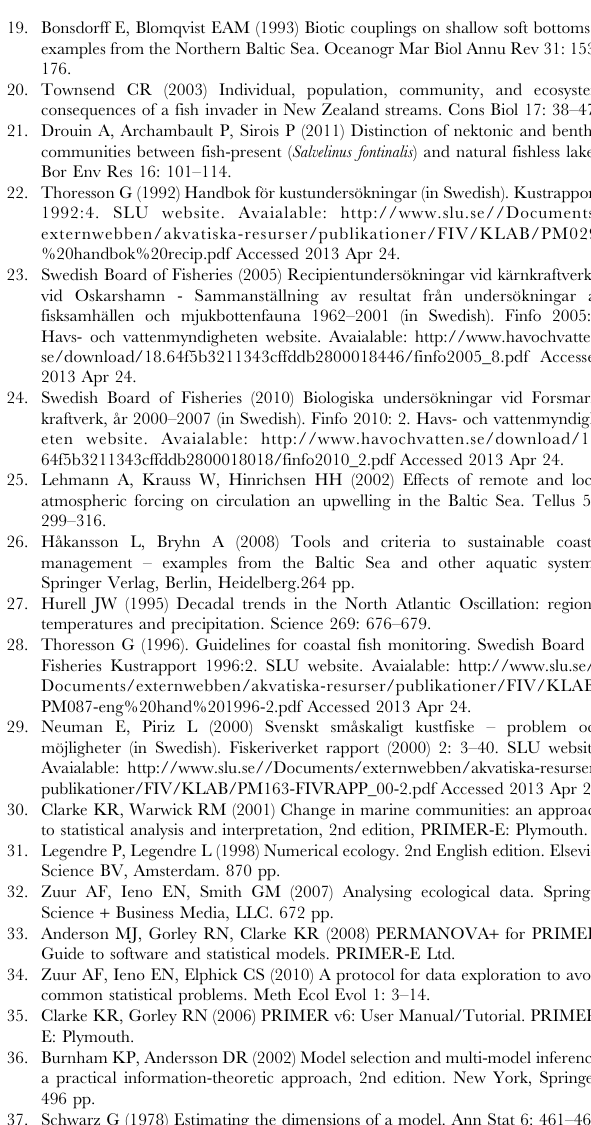
Table S1 Cross-correlation matrix (r-values) for the variables used as predictors for the temporal develop- ment of zoobenthos